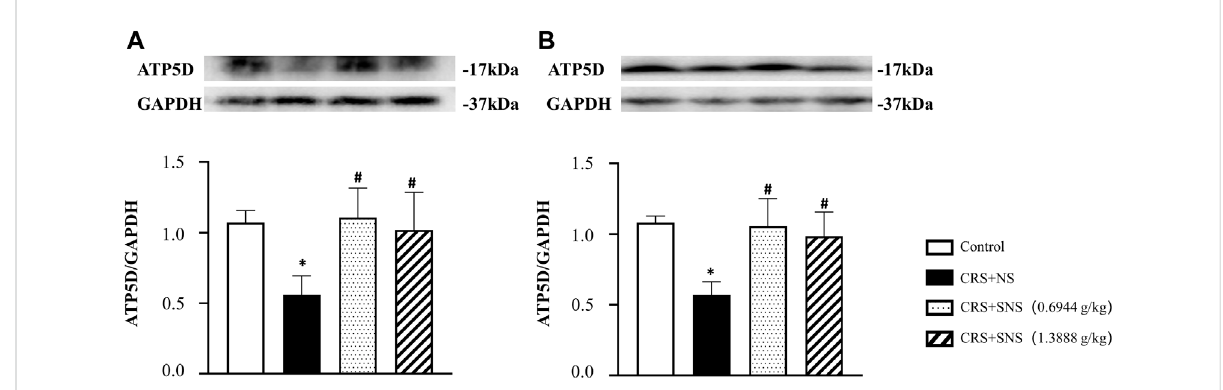
FIGURE 9 EffectoftheSNStreatmentontheexpressionofATP5Dintheileumandcolontissues. (A) WesternblotofATP5Dinileumtissuesfromdifferent groups with quanti fi cation showing below. F = 6.504. p = 0073. (B) Western blot of ATP5D in colon tissues from different groups with quanti fi cation showing below. F = 10.96. p = 0.0009. Results are presented as mean ± SEM. * p < 0.05 vs. Control group; # p < 0.05 vs. CRS + NS group. (A,B) n = 4.